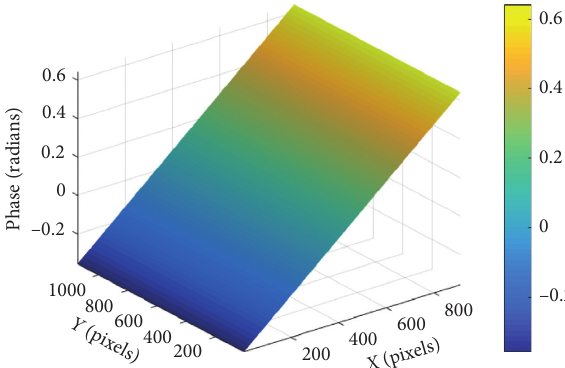
Figure 11: Partial line extraction phase unwrapping.